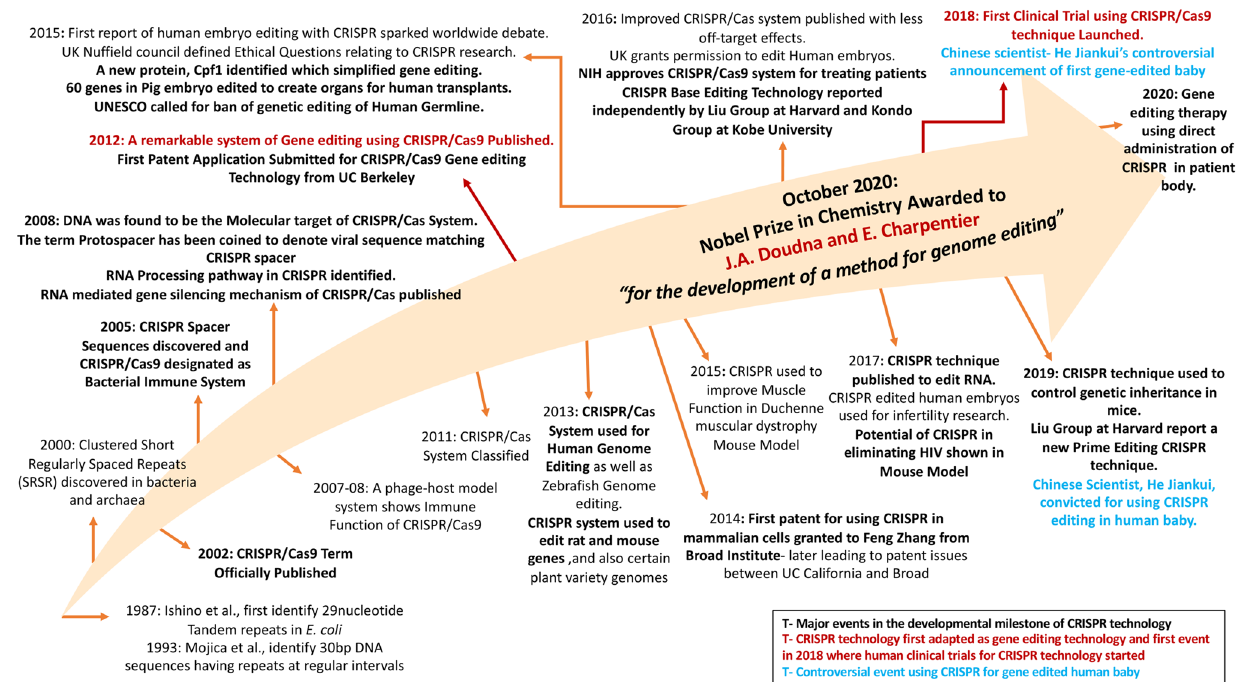
Fig. 1 Timeline of CRISPR